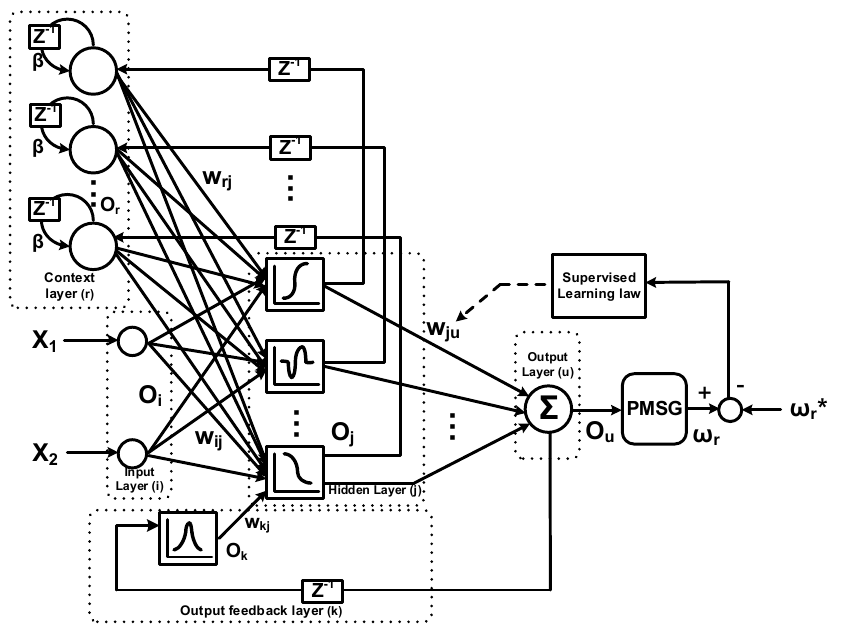
Figure 2. Five − layer RWENN structure diagram.